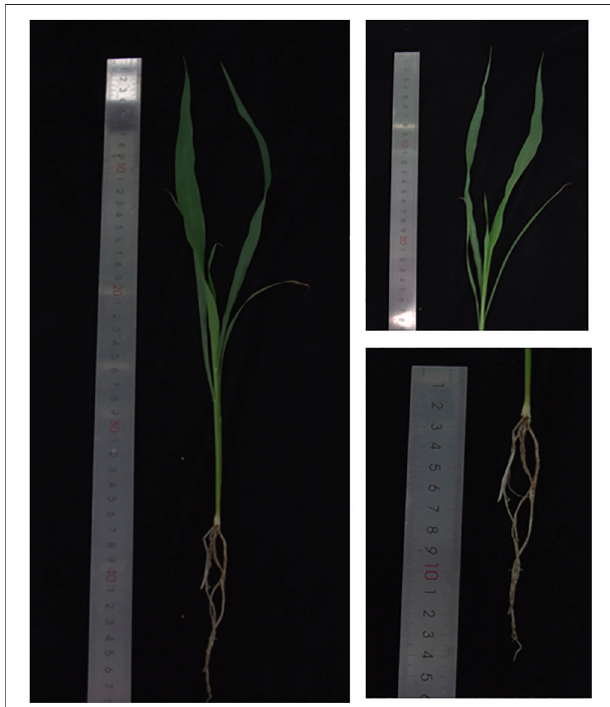
FIGURE1| Morphologicalcharacteristicsof Sorghumdochna asshown in photographs that display a whole plant, leaf, and root.